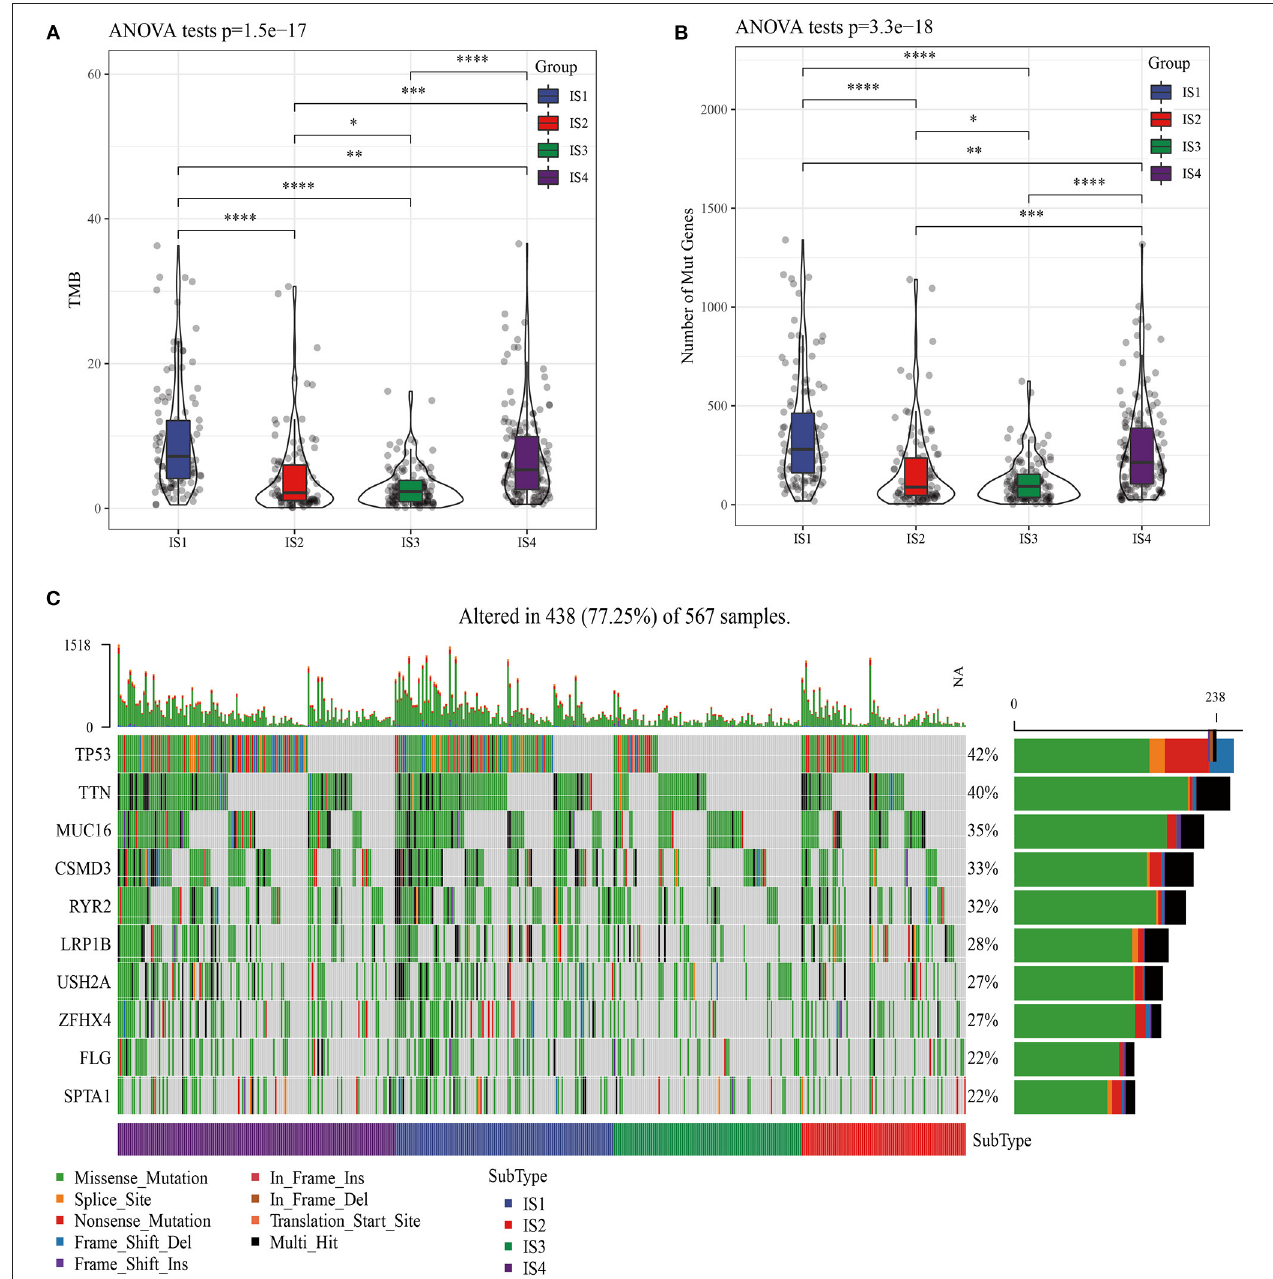
FIGURE 2 | Molecular mutation analysis of four ISs patients in LUAD. (A) Four kinds of ISs of LUAD have different TMB. (B) Comparison of the number of mutant genes in four kinds of ISs. (C) Significant somatic gene mutations in